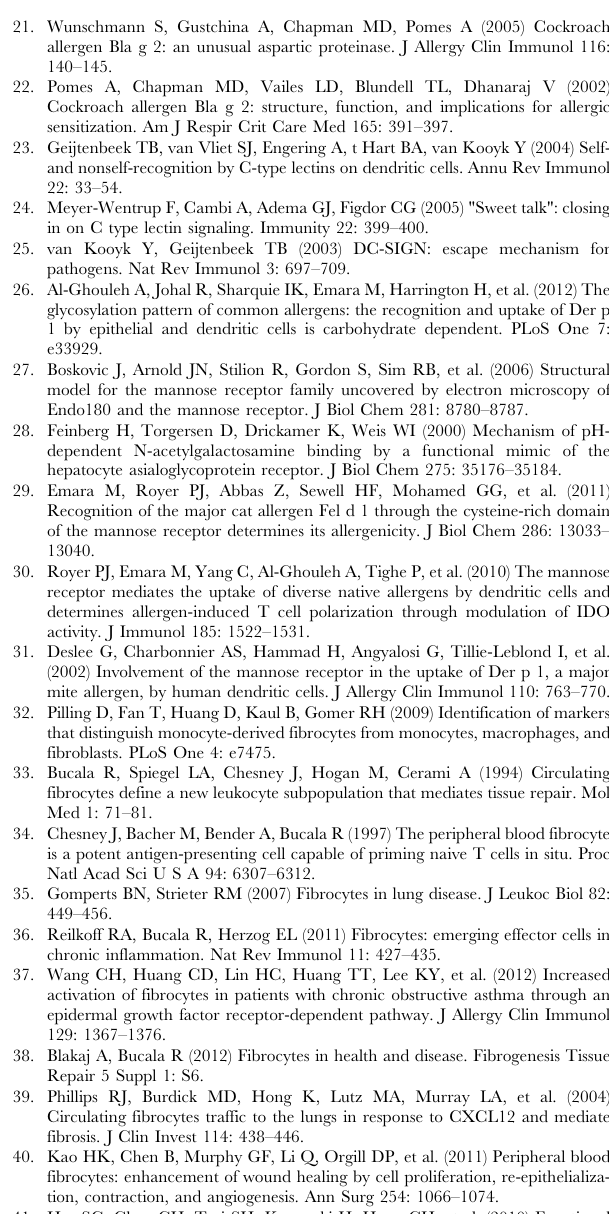
Table S1 Profile of N-linked glycans from Bla g2 by MALDI- MS. Putative structures of N-linked glycans shown in the table were assigned by comparison of measured molecular weights of glycans to those of native glycans using Functional Glycomics glycan database (www.functionalglycomics.org) and SimGlycan software (Premier Biosoft, Palo Alto,